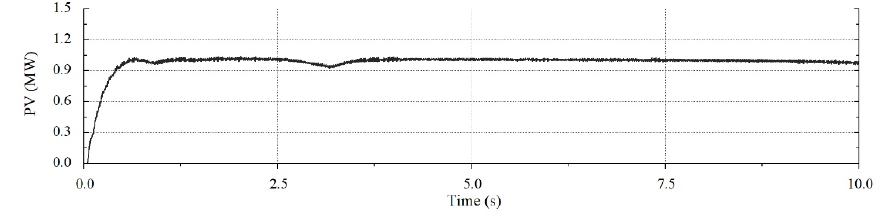
Figure 7. Basic PV production in case study. Table 2. Simulated case study description.